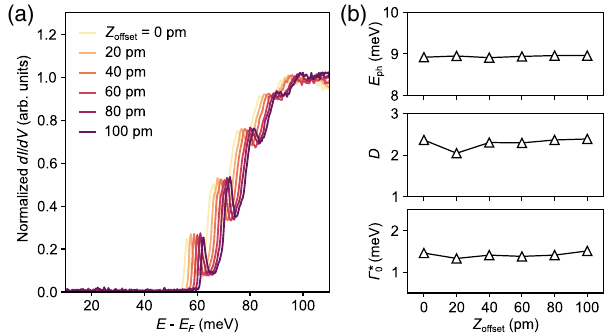
FIG. 4. Insensitivity of Franck-Condon series to tip-sample separation. (a) Conductance curves collected at varying STM tip height. After stabilizing the tip at the height z V ¼ 0 . 11 V, I ¼ 0 . 44 nA), the tip height was altered by an amount z before measuring the conductance spectrum. Here offset the curves are normalized for ease of comparison, using the value of dI=dV at an energy 40 meV above that of the lowest-lying peak. (b) Results of the fitting with the function in Eq. (3). The parameters E , D , and Γ (cid:2) 0 are insensitive to the tip ph